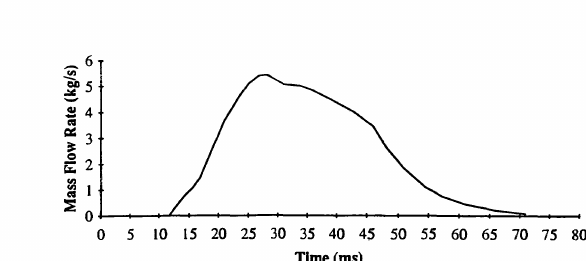
FIGURE 10 The input mass flow rate for nonaspi rated